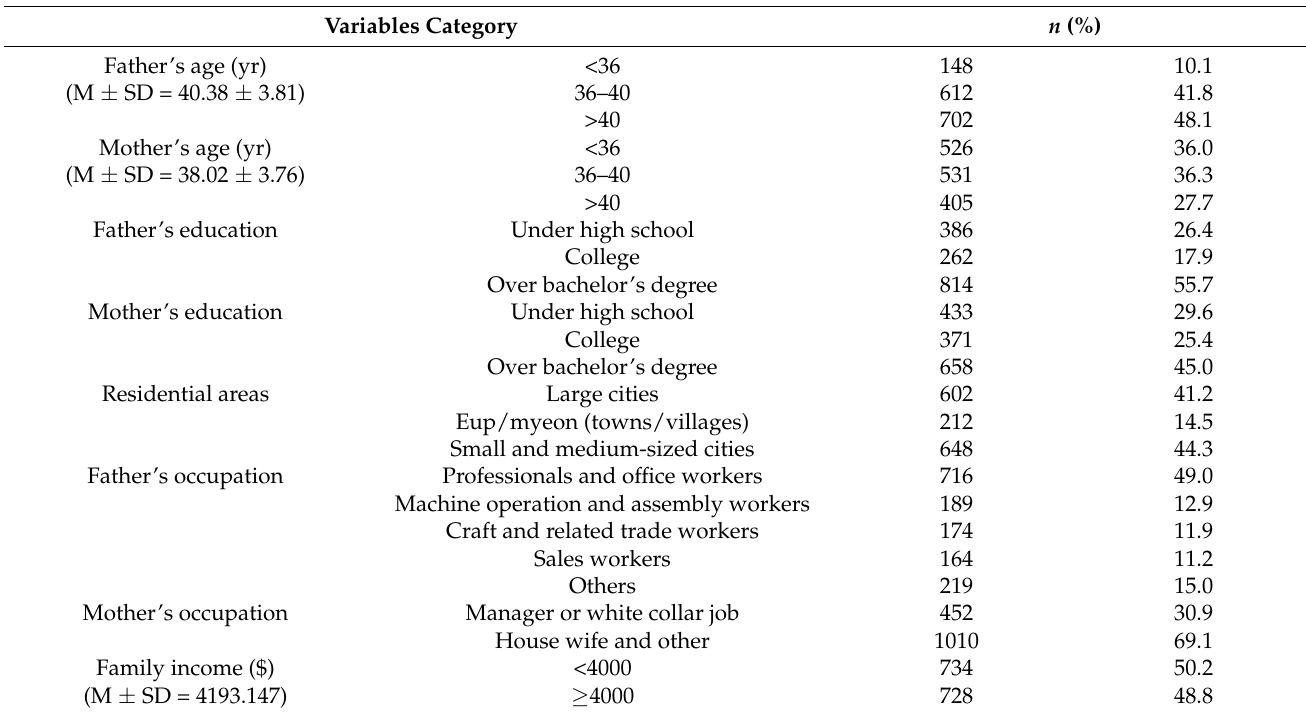
Table 1. Participants’